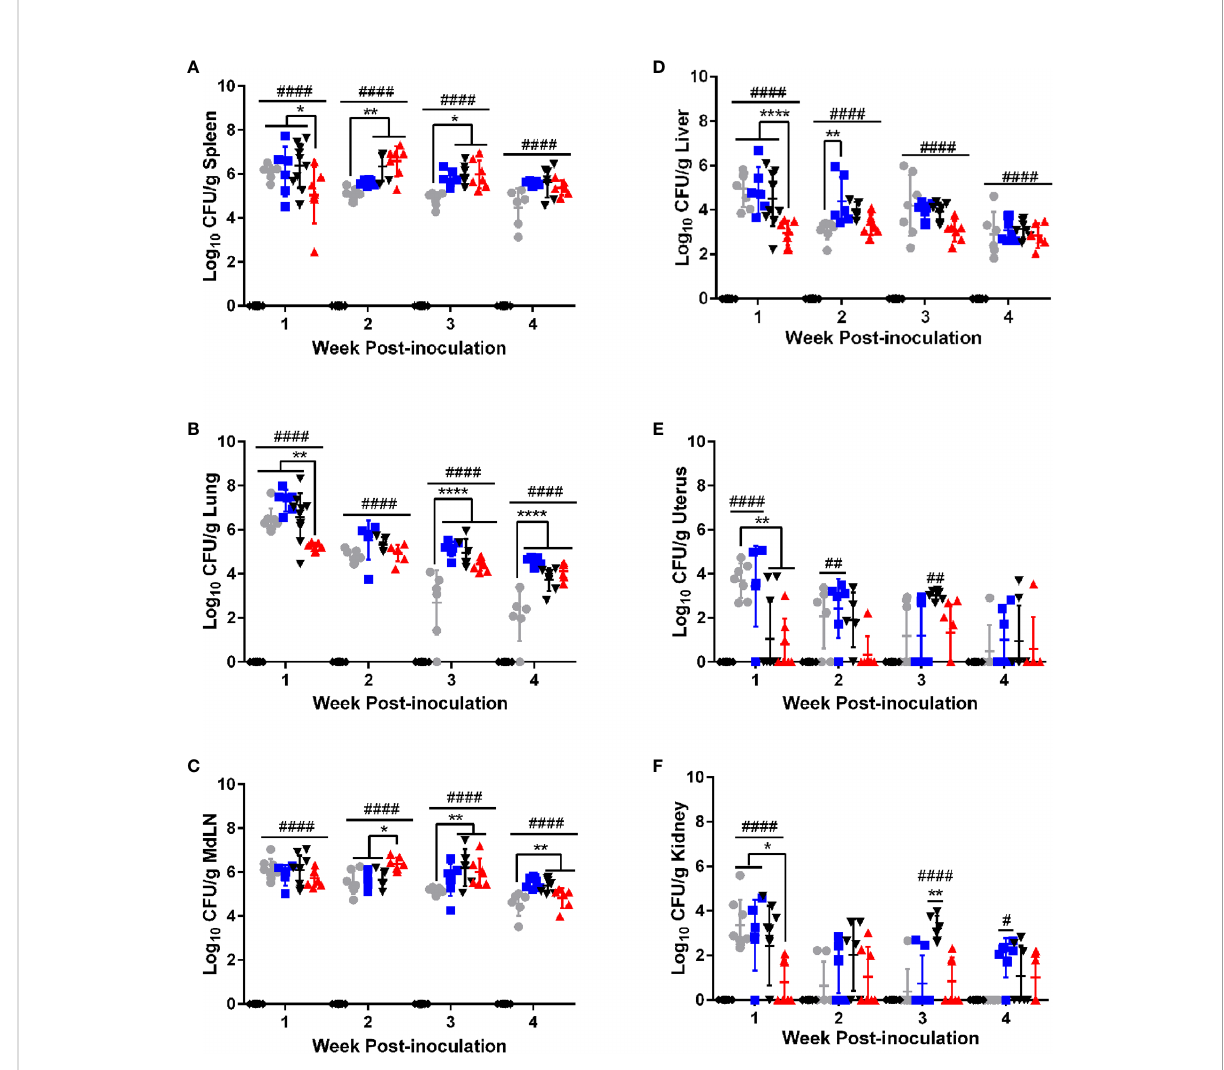
FIGURE 1 B . canis establishes persistent, systemic colonization following intratracheal inoculation comparable to smooth strains. Colonization from 1-4- weeks following inoculation of female C57BL/6J mice with 10 7 CFU B . melitensis, B. abortus , or B . canis , 10 9 CFU B . canis , or PBS in the (A) spleen, (B) lungs, (C) mediastinal lymph node (MdLN), (D) liver, (E) uterus, and (F) kidney. Data points represent the mean bacterial recovery in CFU per gram of tissue plus the standard deviation for all animals in each infection group at each time point. Data were analyzed using two- way ANOVA with Sidak ’ s multiple comparisons test. Signi fi cant differences are depicted between infection groups (*p < 0.05, **p < 0.01, ***p < 0.001, ****p < 0.0001) and between infection groups and the PBS negative control group (##p < 0.01, ####p <